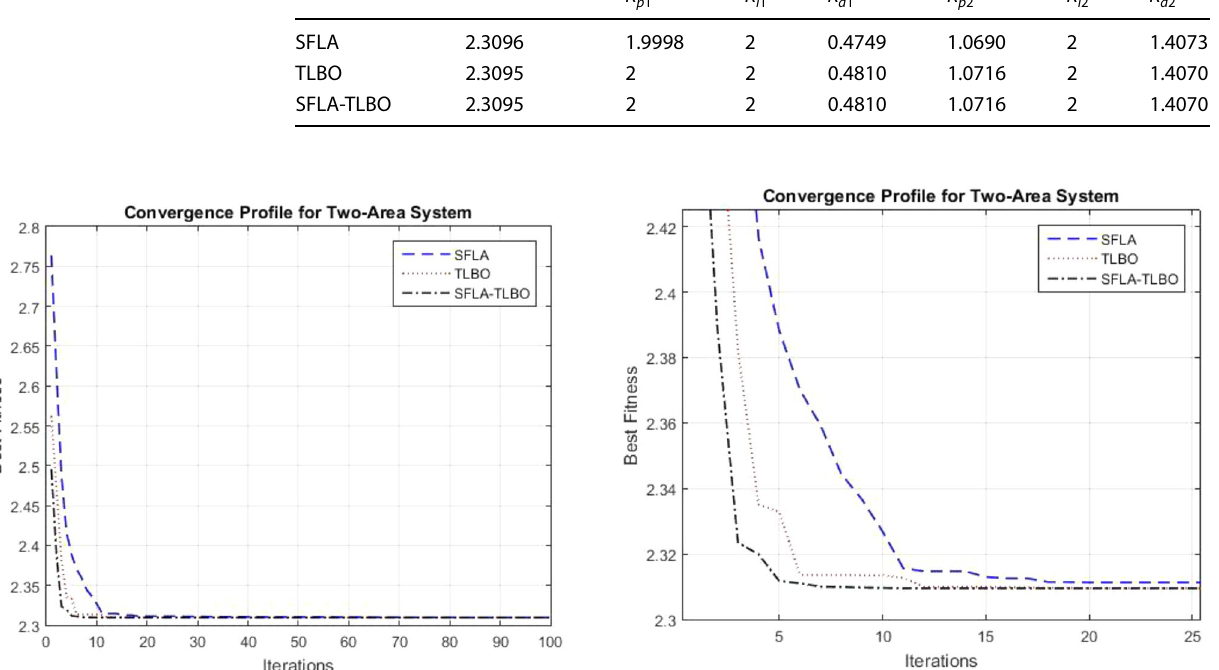
Table 3 Optimal solutions for two-area system